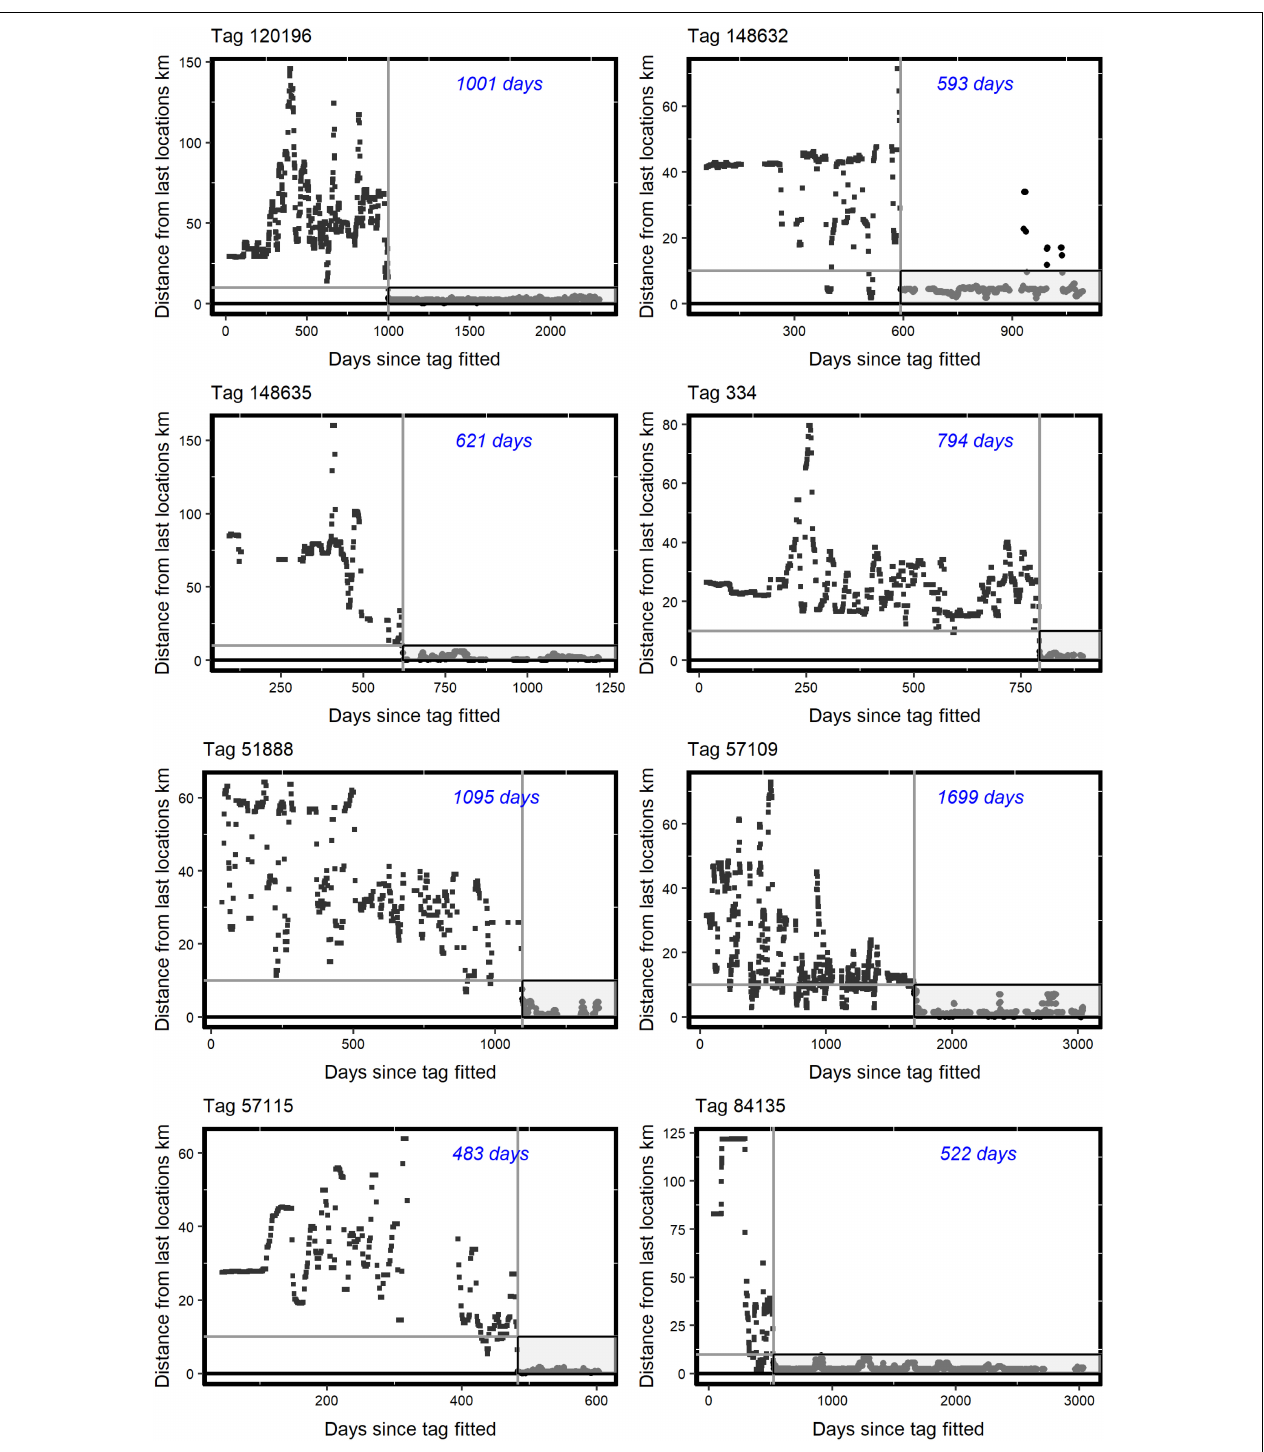
FIGURE 1 | Examples for eight tagged birds (identified, upper left above each panel) deemed to have algorithmically settled on a putative breeding territory according to Distance from last locations (km) in the Y axes, against Days since tagged fitted in the X axes. The Y axes values were based on available median nocturnal locations and refer in distance to the median location 10 days earlier. The vertical grey line identifies the putative settlement date and the horizontal grey line shows the Assumption 2 threshold of 10 km (see main text). The “settlement period,” after the putative settlement date, and according to the Assumption 2 10 km threshold, is shown in greyscale. The italicised blue value (in days: top right within each panel) shows the time between tagging and putative territory settlement. The R code in Supplementary Appendix B provides for such plots.